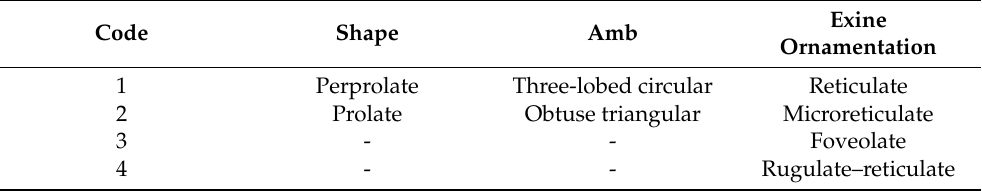
Exine Ornamentation